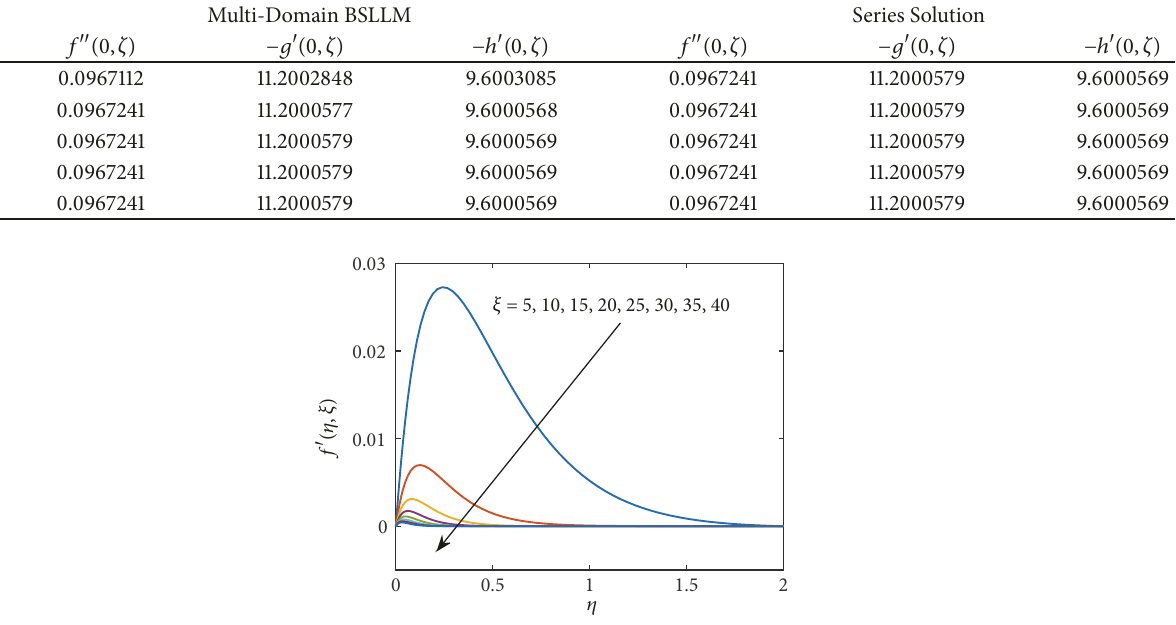
Figure 3: Velocity profiles at different values of 𝜁 , 𝑁 𝜂 = 60 , 𝑁 𝜁 = 5 , 𝑛 = 𝑤 = 1/2 , 𝑃𝑟 = 0.7 , 𝑆𝑐 = 0.6 , and 𝑧 = 40